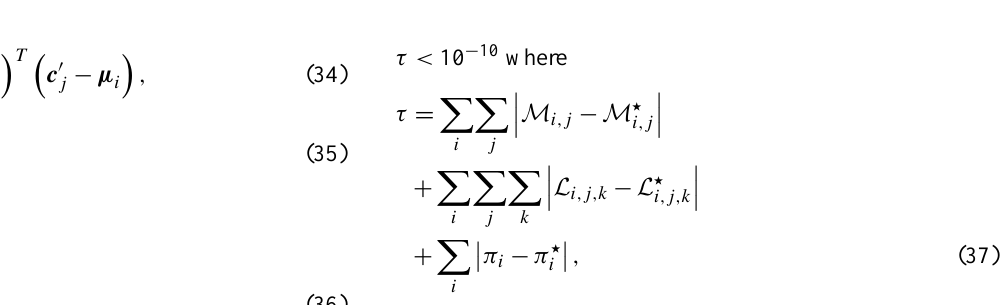
Figure 2. Gaussian mixture model (GMM) representation of methane emissions in Southern California with Gaussian pdfs as state vector elements. The Gaussians are constructed from a simi- larity matrix for methane emissions on the 1 olution of the GEOS-Chem CTM used as forward model for the in- version. The figure shows the dominant three Gaussians for South- ern California with contours delineating the 0.5, 1.0, 1.5, and 2.0 σ spreads for the latitude–longitude dimensions. The RBF weights w 1 , w 2 , and w 3 of the three Gaussians for each 1 are also shown along with their